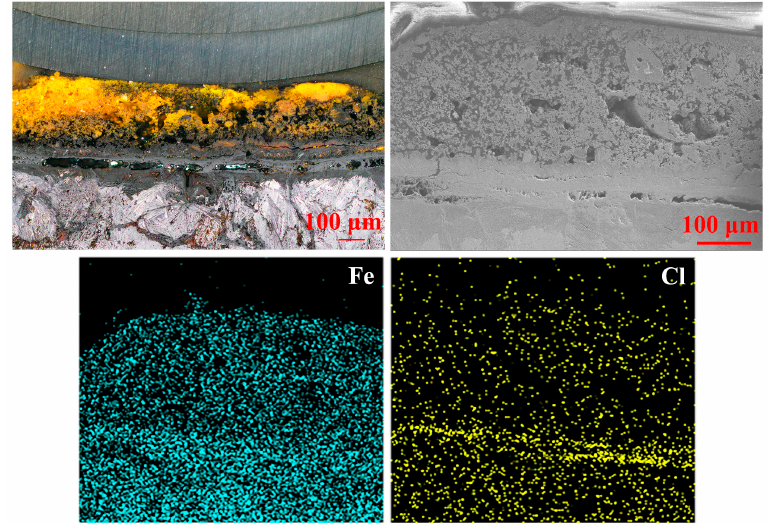
Figure 7. Graphs of the microstructure and element distribution of rust layer B.